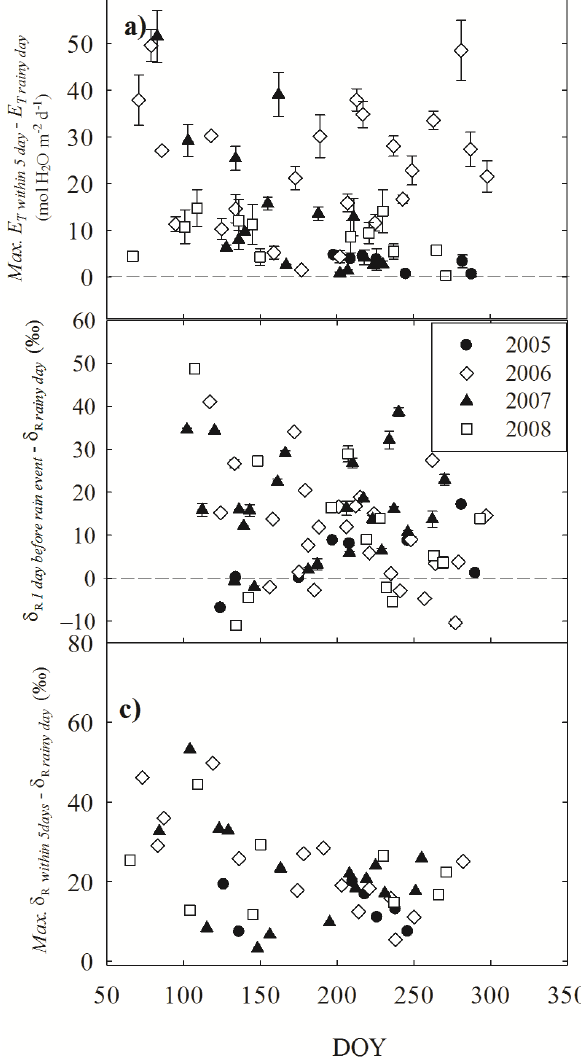
Fig. 4. (a) The differences in E T between the day of a rain event and the maximum value over the subsequent five days. Positive val- ues indicate E T was higher after the rain event than before. All rain events were included from DOY 60 to 300. (b) The difference in δ R between 1 day before a rain event and δ R on the rainy day, shown for 2005–2008. Positive values indicate δ R values become more depleted by the rain event. (c) The difference in normalized δ R between the night of a rain event and the maximum value over the subsequent five nights. δ R values were normalized by the day zero δ R after a rain event to make all starting values zero over the four years, thereby allowing examination of the response to the rain event. The maximum normalized δ R values within 5 days after pulse events typically captured the maximum enrichment (Fig.